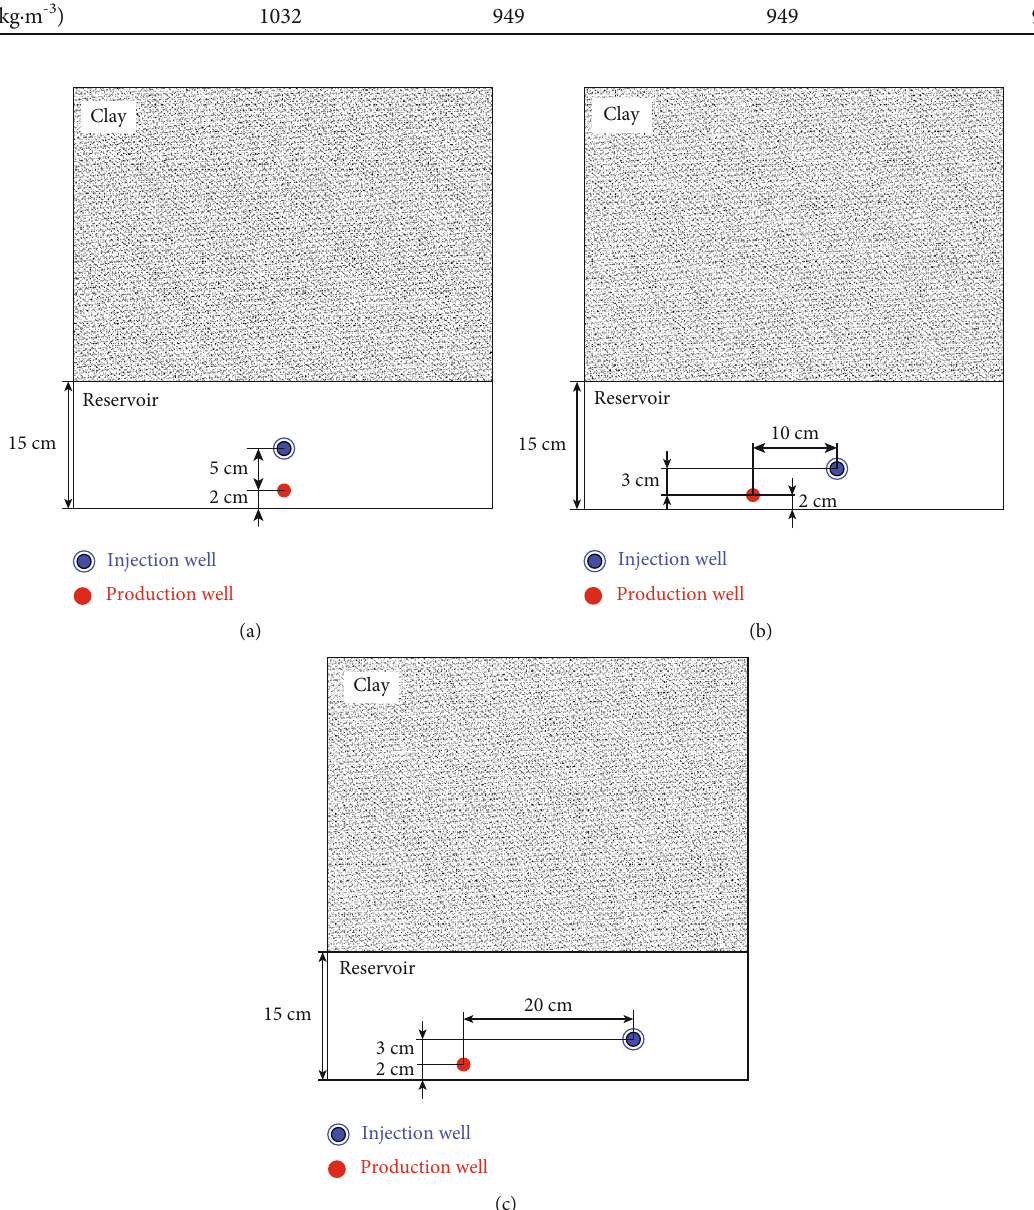
Figure 5: The schematic diagram of well placement. (a) Horizontal distance was 0cm. (b) Horizontal distance was 10 cm. (c) Horizontal distance was 20